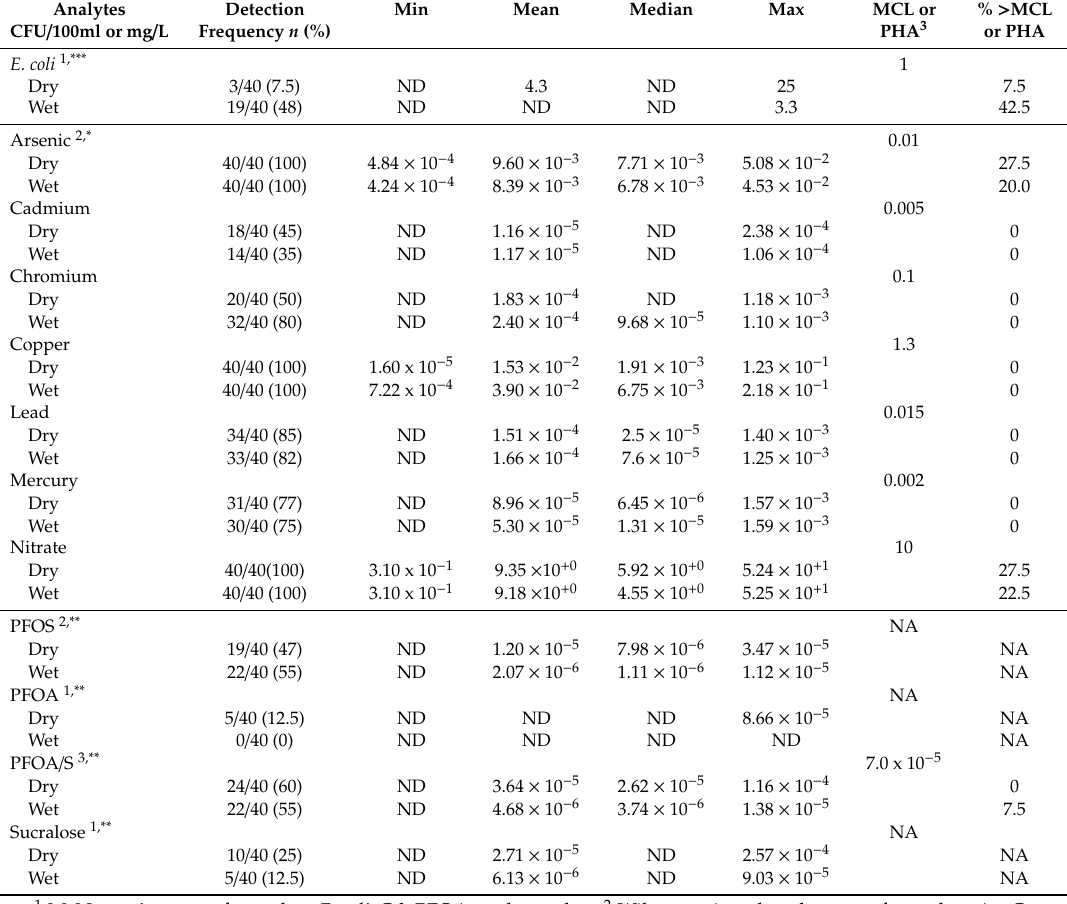
Table 3. Summary of microbial, inorganic, and organic contaminant concentrations by season. Analytes CFU / 100ml or mg /